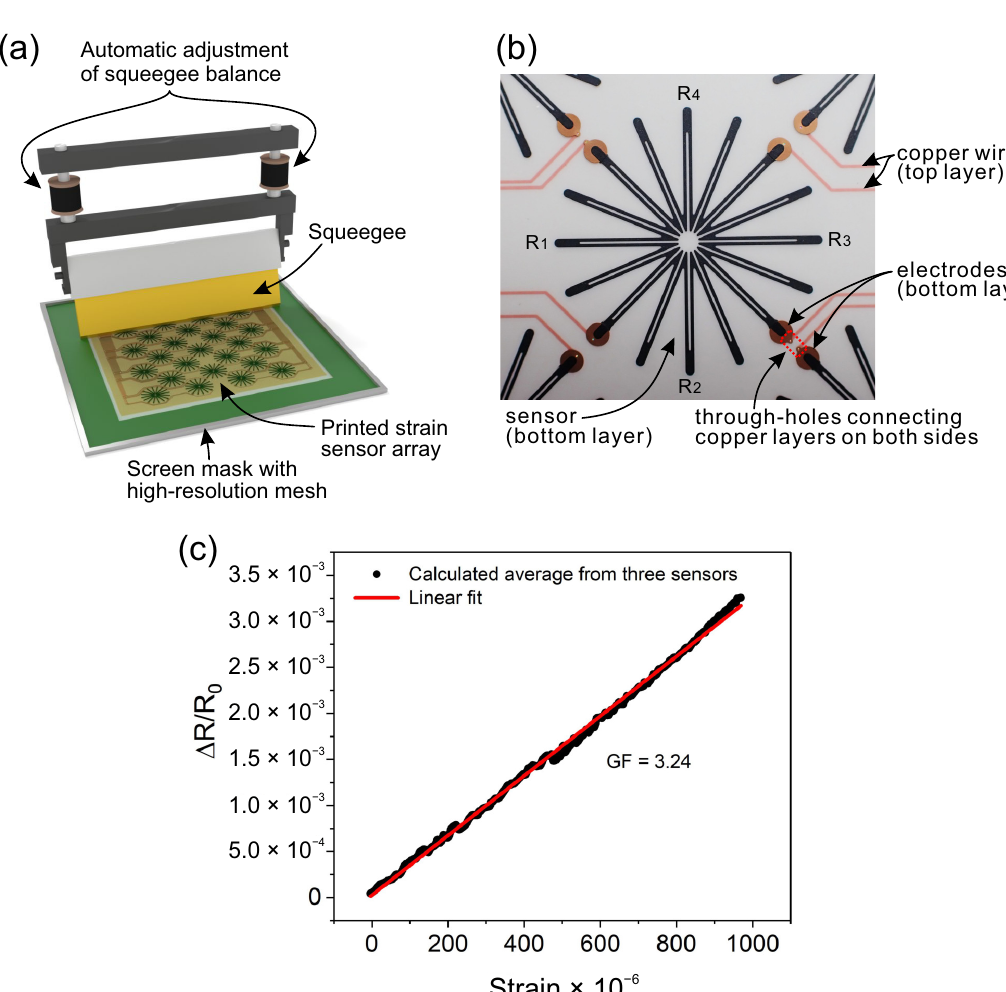
Figure 1. ( a ) Screen printing of the strain sensor array. ( b ) Back view of a single strain sensor incorporated into the array of 25 sensors. R 1 − 4 show the particular resistive elements of the printed structure that complete the full-Wheatstone-bridge circuit. ( c ) Strain sensitivity calculated based on the average of three printed strain